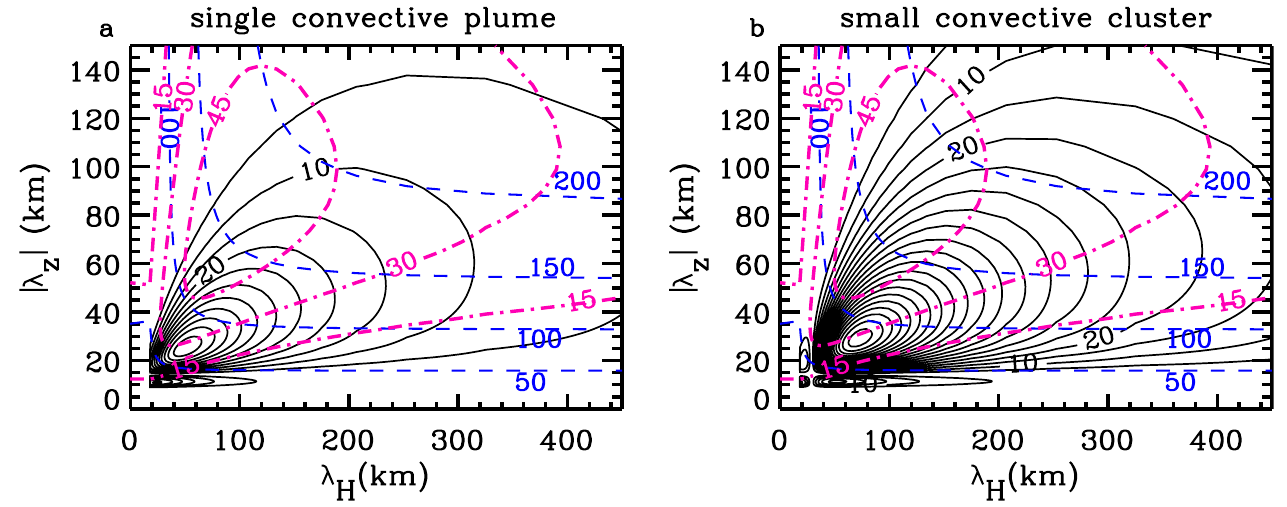
Fig. 16. GW horizontal velocity amplitudes at z = 87km in intervals of 5m / s (light solid lines). These are the maximum amplitudes at this altitude. (a) Single convective plume with ground reflection. (b) Small convective cluster with ground reflection. Pink dash-dot lines indicate c gz in 15ms − 1 intervals. Blue dash lines indicate c H in 50ms − 1